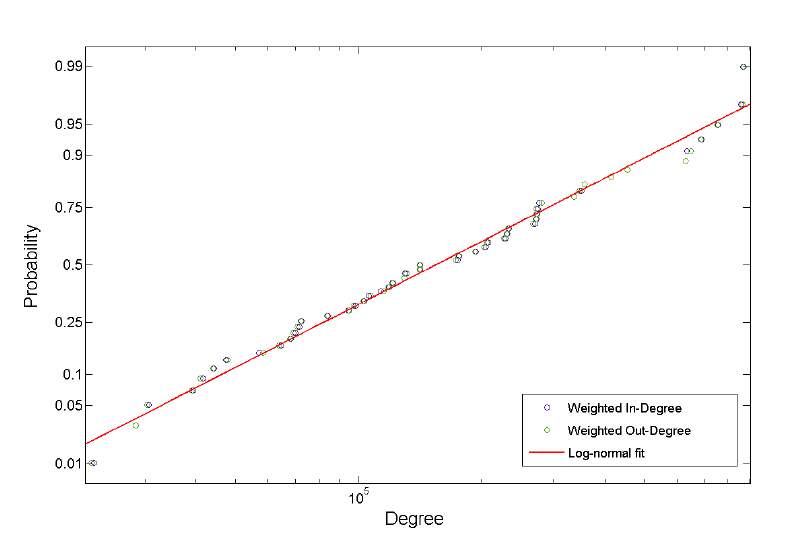
Figure 7. The distribution of Twitter user movement flows among different states in the year 2014 measured in weighted in- and